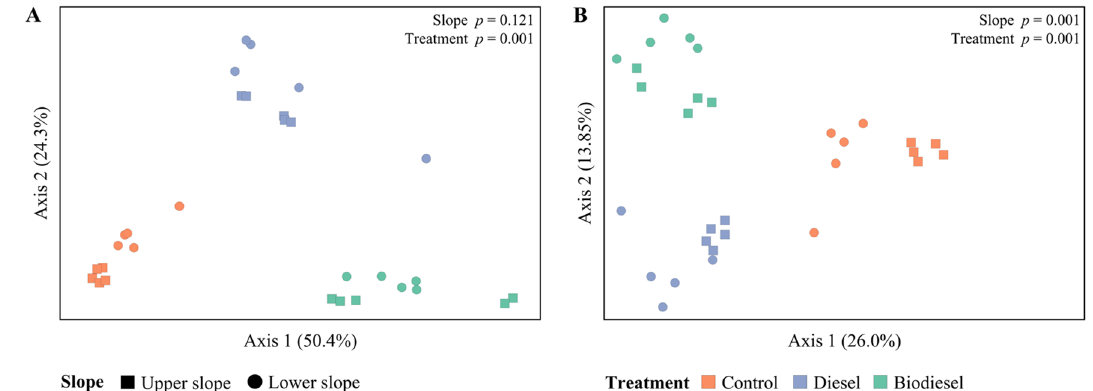
Figure 4. Principal coordinate analysis (PCoA) based on ( A ) weighted and ( B ) unweighted unifrac distances between soil samples for treatment and slope (n = 5). Adonis test (999 permutations) was used to determine differences in community composition between groups ( p values